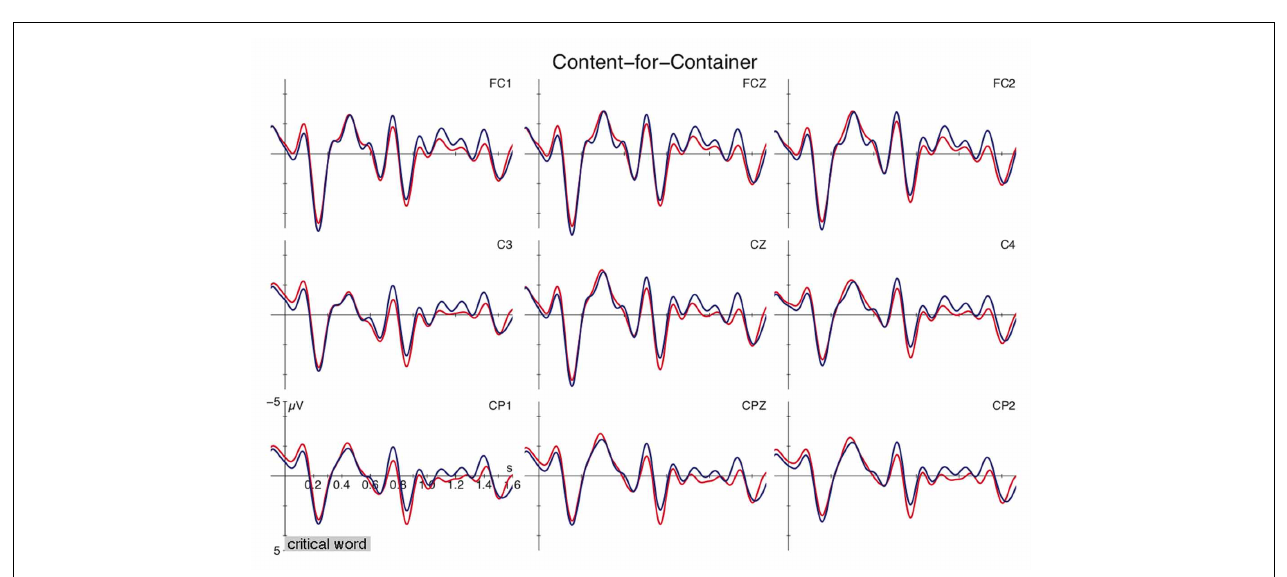
(red). The onset of the critical expression is at vertical bar; the presentation of the subsequent segment started at 0.6s. Negativity is plotted upwards.